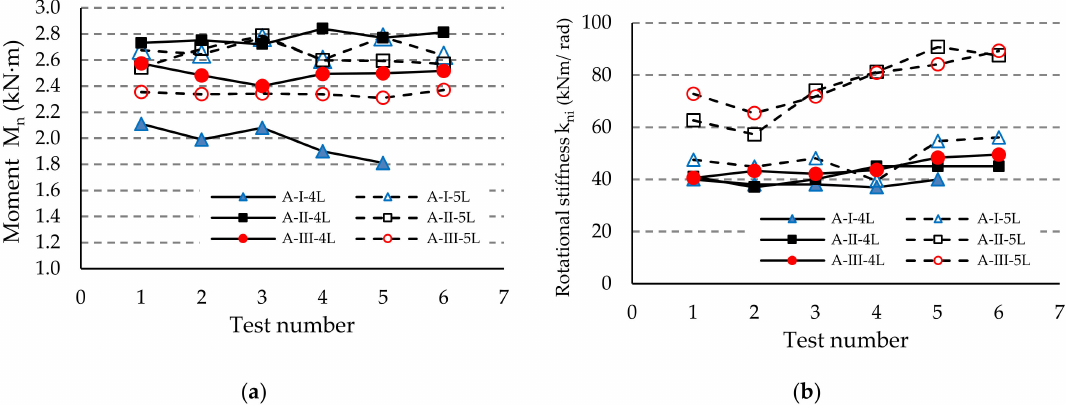
Figure 12. Comparison of the results obtained for the assemblies with the beam of type A concerning: ( a ) capable corrected moment M n , and ( b ) rotational sti ff ness k ni of the